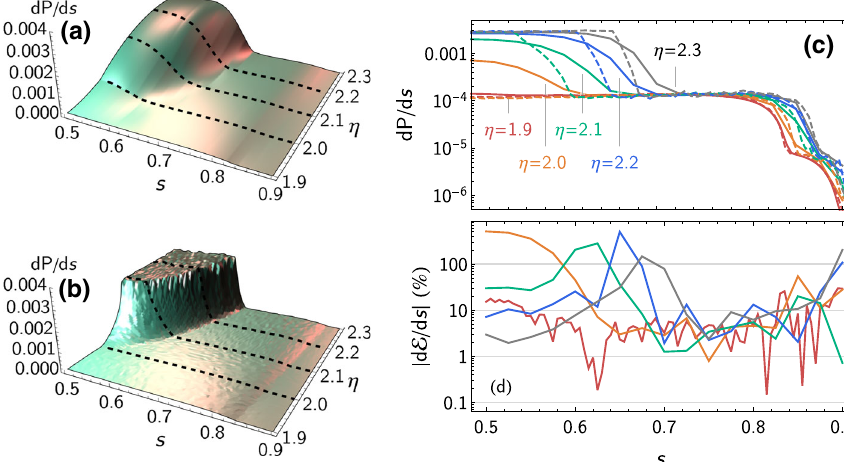
Fig. 6 Positron lightfront-momentum spectra d P / d s around the n = 1 channel crossing, for a laser pulse with peak amplitude ξ = 0 . 2 and N = 16: a results from QED and b LMA-based simulations. c Spectra at specific values of η , from QED (solid) and simulations (dashed) from the energy parameter region indicated in Fig. 5a. d